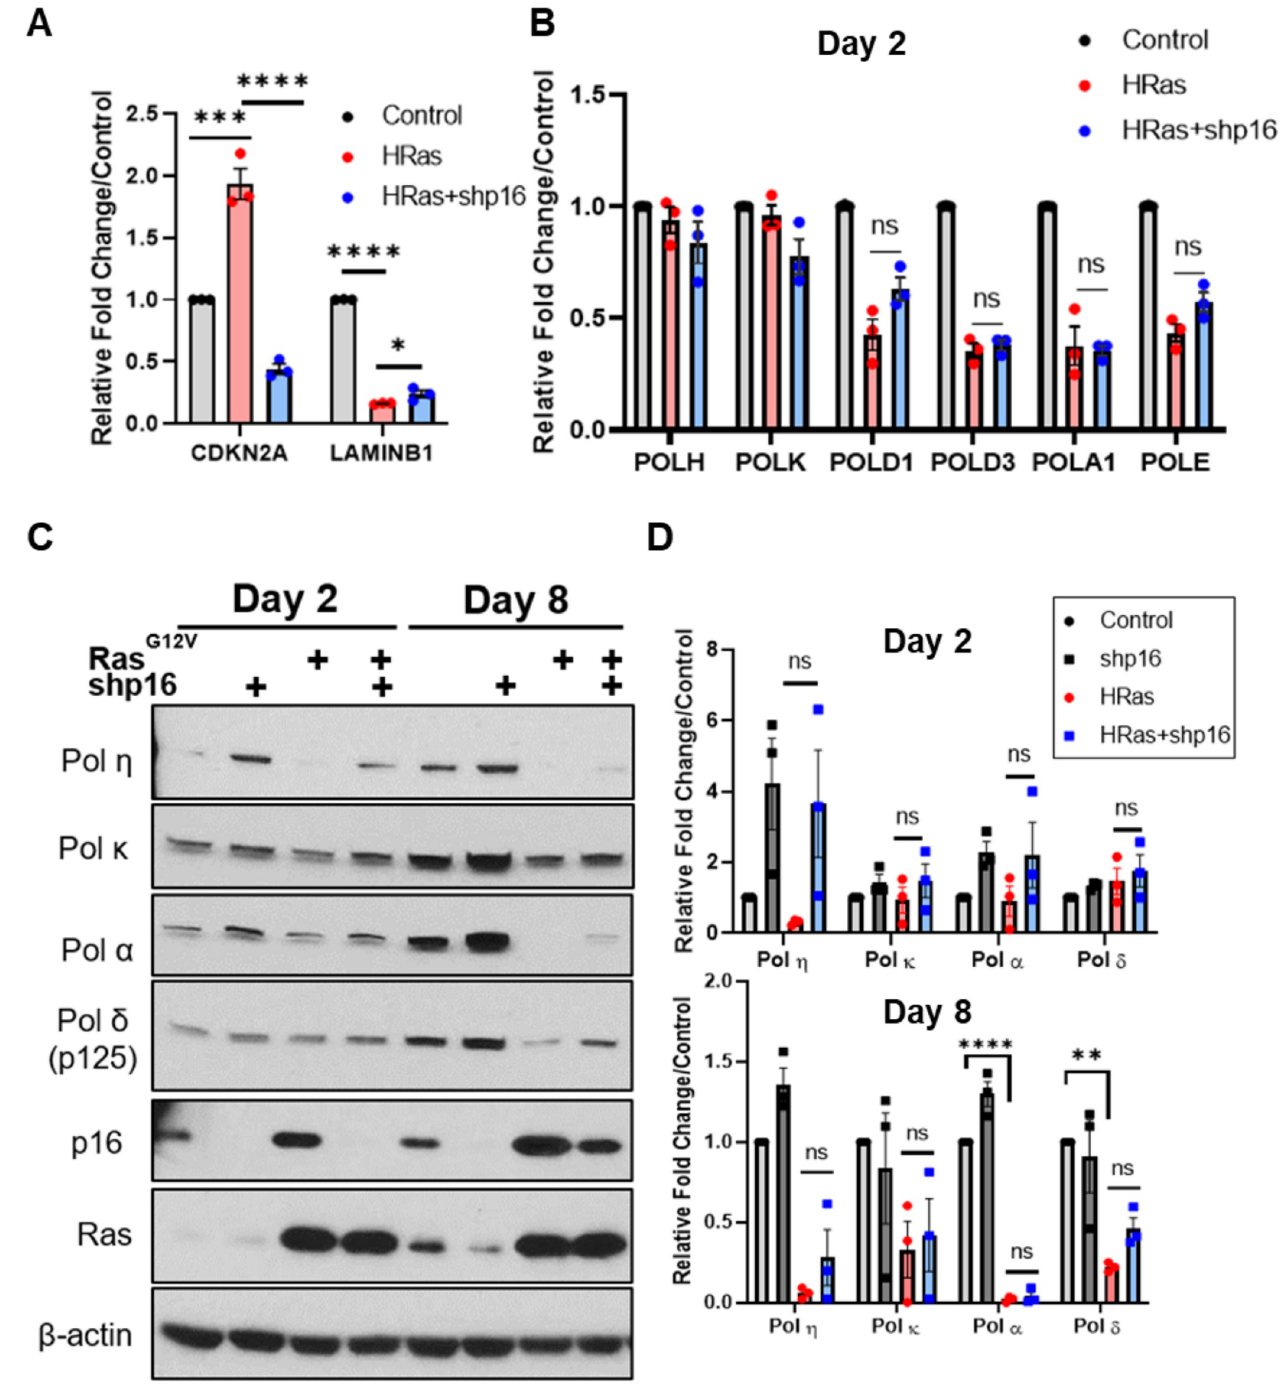
Fig 4. Relationship of p16 to DNA polymerase expression in response to oncogenic Ras G12V signaling. hTERT -BJ5a cells were infected with lentivirus expressing short hairpin RNAs (shRNAs) targeting CDKN2A . Scrambled shRNA was used as control. (A) mRNA expression analysis of senescence markers on Day 2 as determined using qRT-PCR. (B) mRNA analyses of DNA polymerase gene expression on Day 2 as determined using qRT-PCR. Data represent mean +/- SEM from three biological replicates. Statistical analyses were performed using One-way ANOVA with Tukey’s post-hoc. n.s., not significant. � p < 0.05, ��� p < 0.005, ���� p < 0.0001. (C) Immunoblot analyses of control or Ras G12V BJ5a cells, with and without p16 knockdown. Data are representative of three independent replicates. (D) Quantification of control or Ras G12V BJ5a cells immunoblot analyses, with and without p16 knockdown. Statistical analyses were performed using One-way ANOVA with Tukey’s post-hoc. �� p < 0.005, ���� p < 0.0001, n.s., not significant.